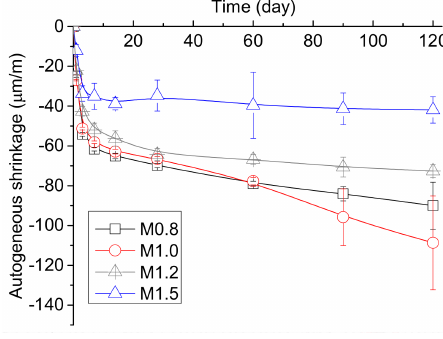
Figure 11. Autogeneous shrinkage of the geopolymer